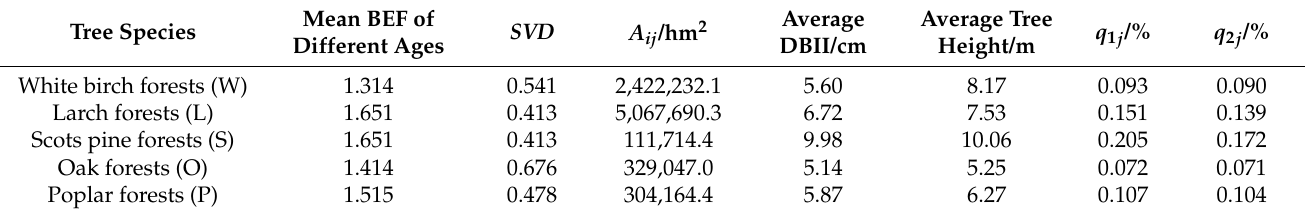
Table 1. Survey and statistical table of basic data of five forest types in the Great Khingan region [38]. Mean BEF Tree Species